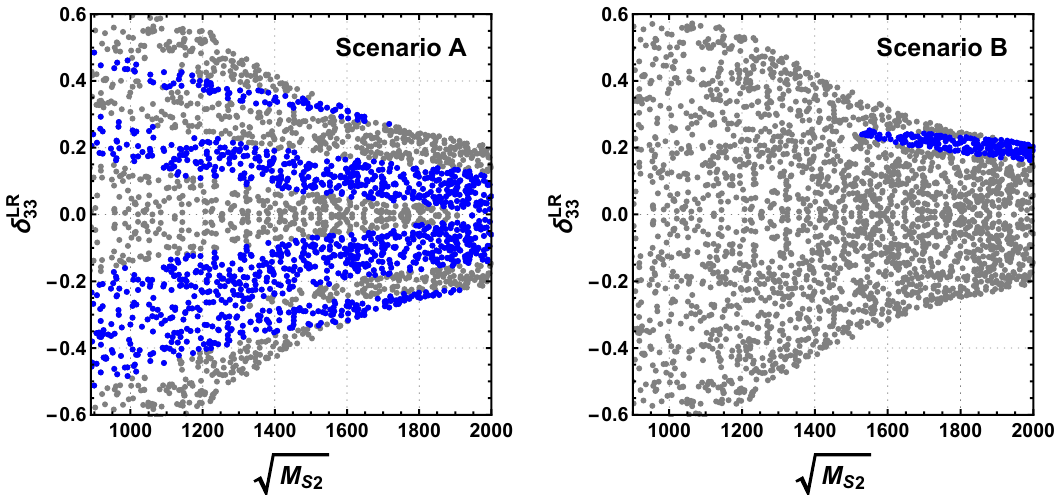
Figure 1 . Allowed regions (blue dots) for the parameters M S SM-like Higgs mass in scenarios A (left) and B (right), respectively. The gray dots indicate that the SM-like Higgs mass is not in the range 122 GeV 6 m H